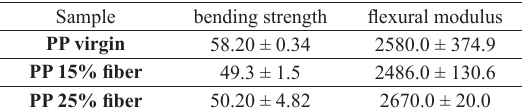
Figure 5. 3-point bending test for the composite PP 25% fiber. Table 8. 3-point bending strength results.